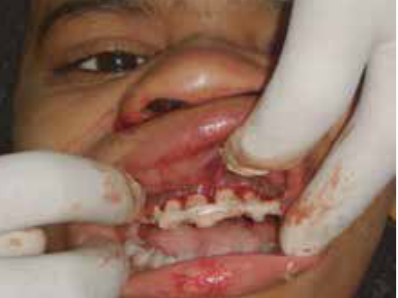
Fig 5. Re-implantation of teeth